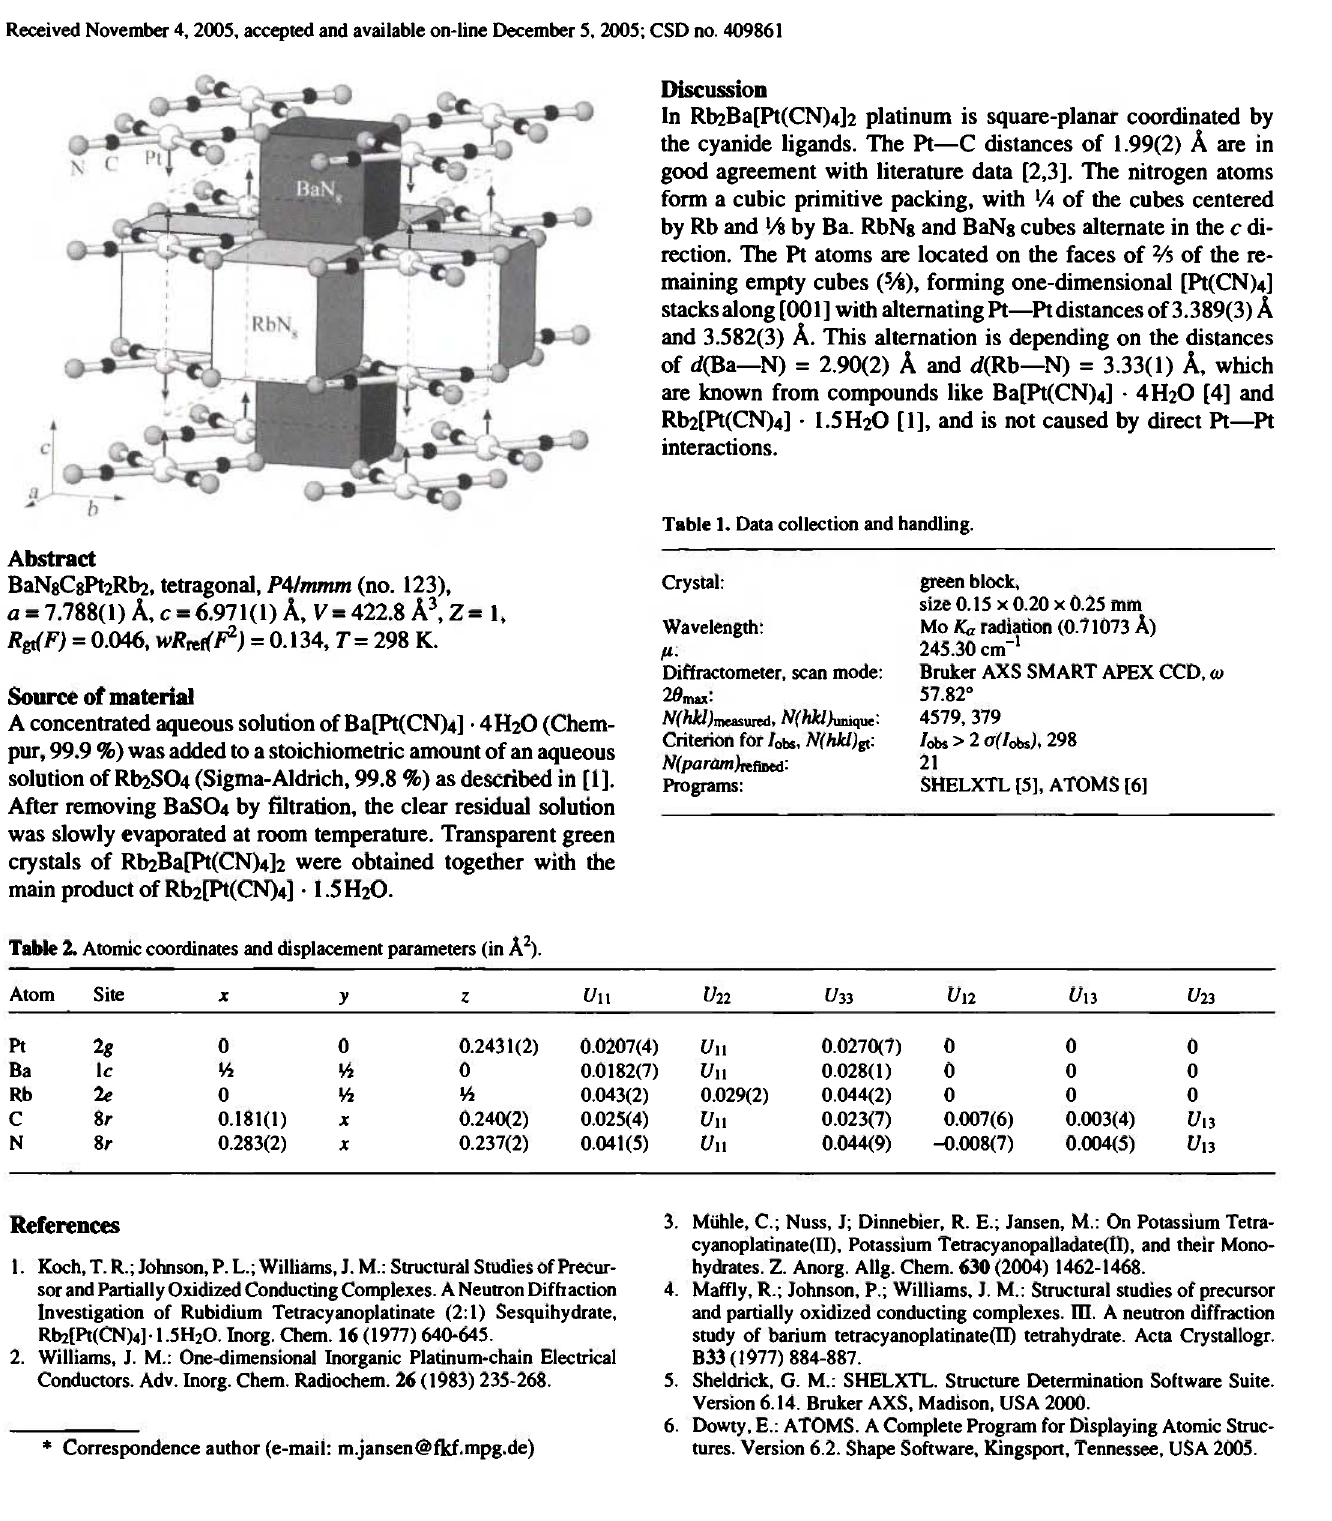
Table 2. Atomic coordinates and displacement parameters (in A 2 ).